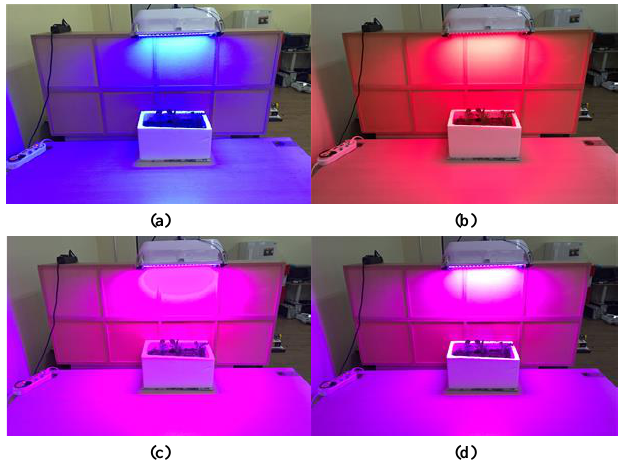
Figure 7. Total power comparison according to various distances and ambient PPFD. Figure 8. Plant cultivation test for the proposed LED control system using red/blue LED PWM signals: ( a ) 0/255; ( b ) 255/0; ( c ) 128/128; and ( d ) 255/255.